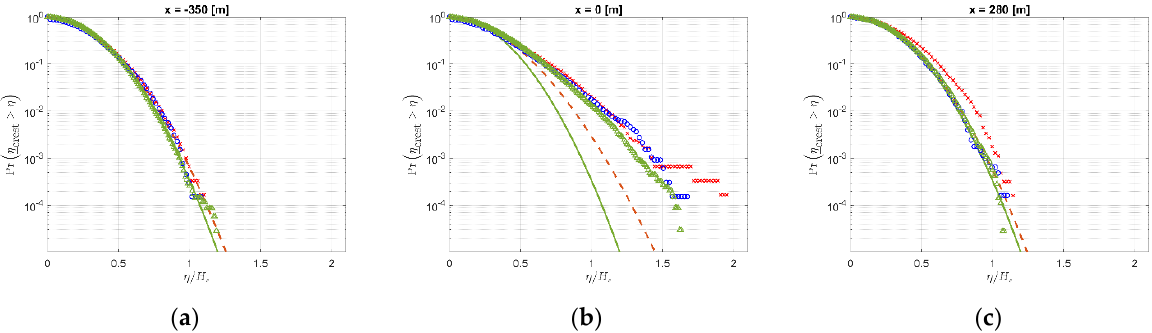
Figure 10. The crest and trough exceedance for H2.5T11 over the main interval for ( a ) simulation of 1D long-crested waves, ( b ) measurement, and ( c ) simulation of short-crested waves. Figure 11. Crest exceedance at ( a ) x = − 350, ( b ) x = 0, middle of shoal, and at ( c ) x = 280 for H2.5T11 showing the standard Rayleigh (green solid) and Forristall 3D (red dashed) distributions [18], the experimental values (blue circle), the short-crested simulation (green triangle), and the 1D long-crested simulation (red cross).